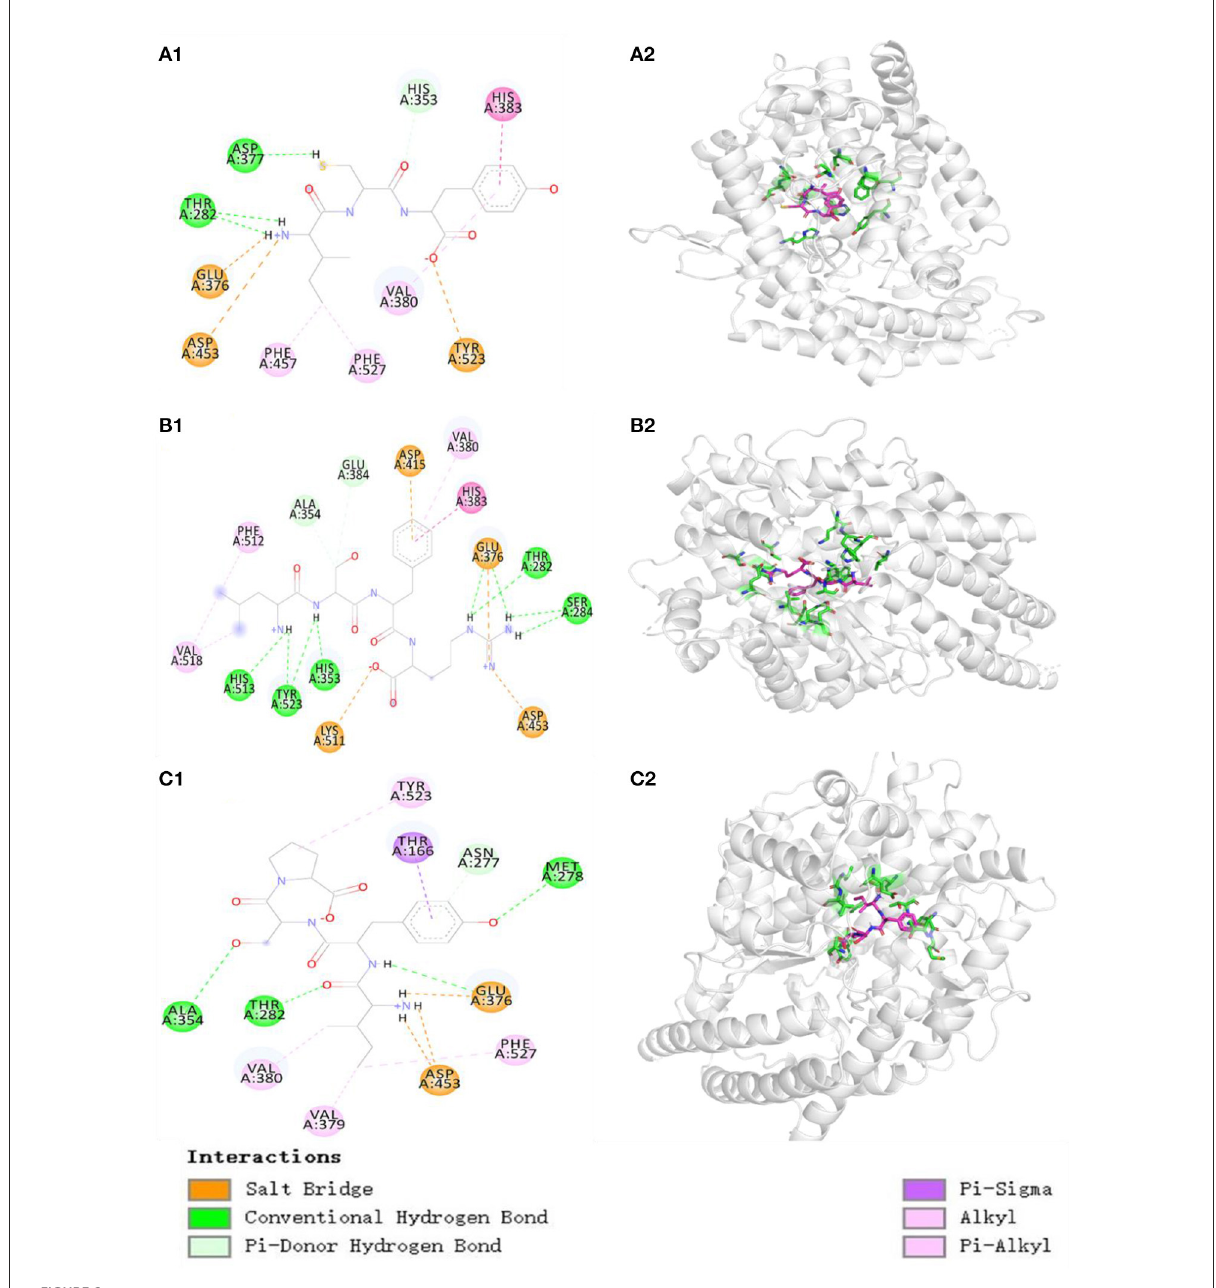
FIGURE6 Molecular docking results of TP6, TP7, and TP10 with ACE. (A1) 2-D details of ACE and TP6 interaction. (A2) 3-D interaction details for TP6; (B1) 2-D details of ACE and TP7 interaction. (B2) 3-D interaction details for TP7; (C1) 2-D details of ACE and TP10 interaction. (C2) 3-D interaction details for